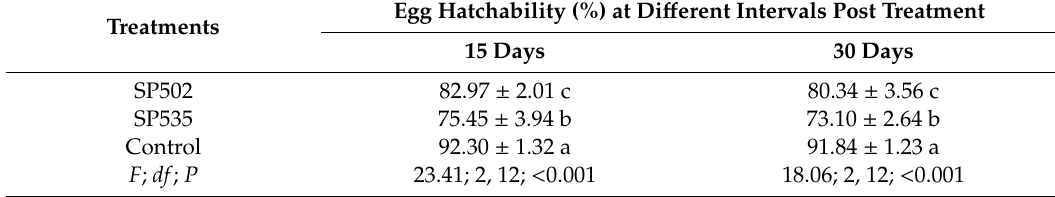
Table 1. E ff ect of C. fumosorosea colonization of egg hatchability (%) of B. tabaci.